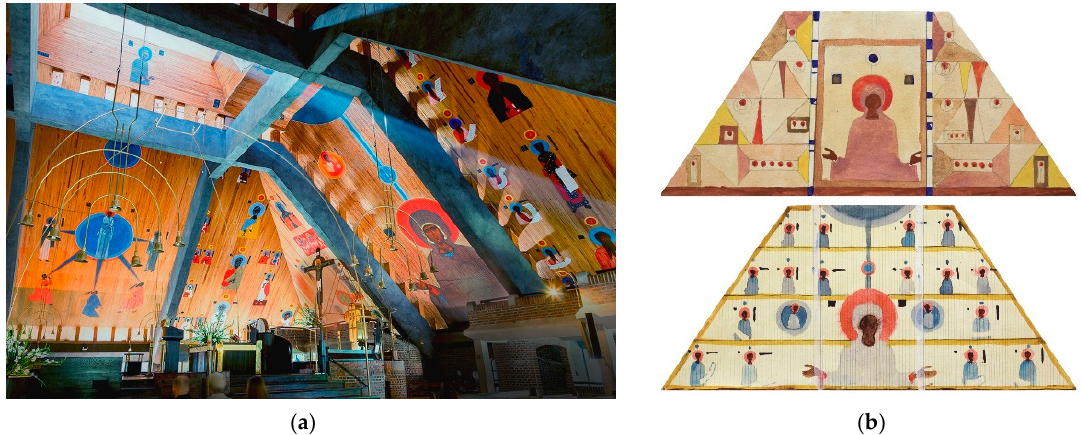
Figure 12. Catholic church in Tychy. ( a ) View of the interior. Photography by the author. ( b ) Jerzy Nowosielski, Variants of the polychrome, 1983. Photography by M. Gardulski/Galeria Starmach. Reproduced with permission.